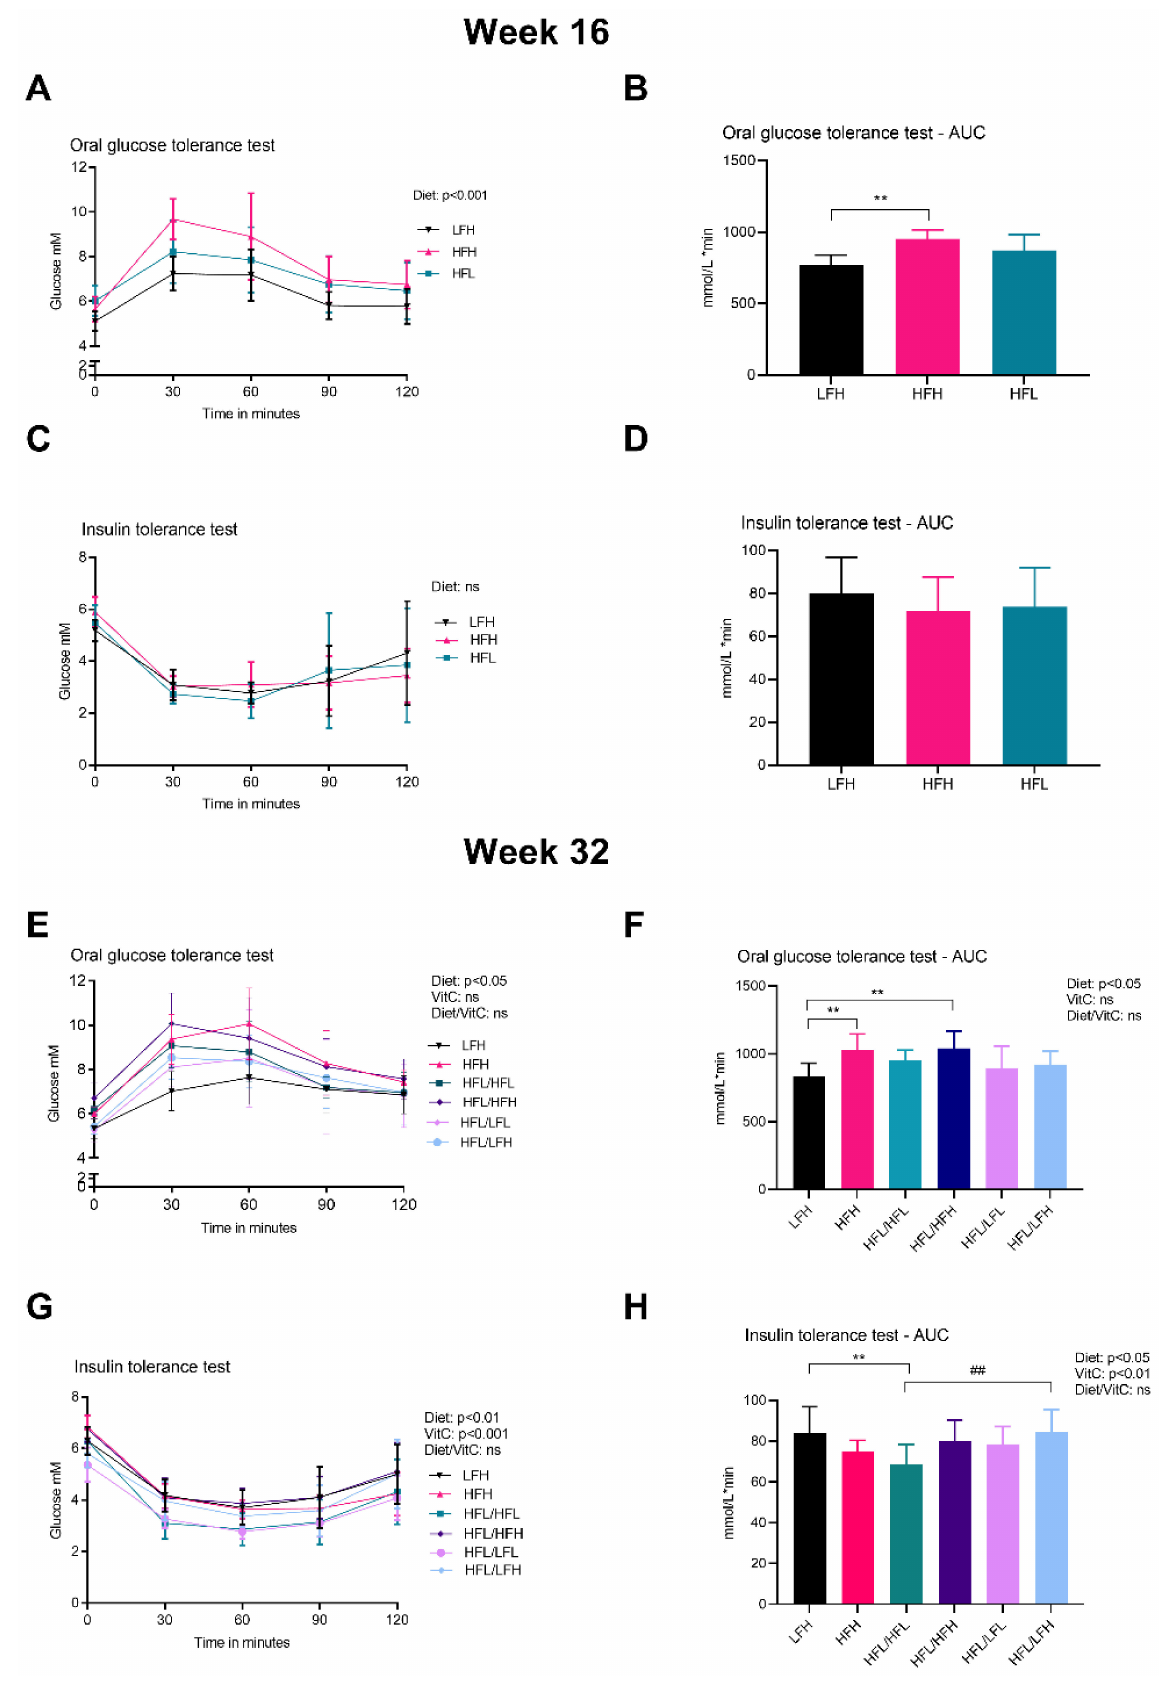
Figure 2. Glucose homeostasis. ( A ) OGTT at week 16. Log transformed data were analyzed by a two-way ANOVA (only results from the overall ANOVAs are shown). ( B ) AUC for OGTT at week